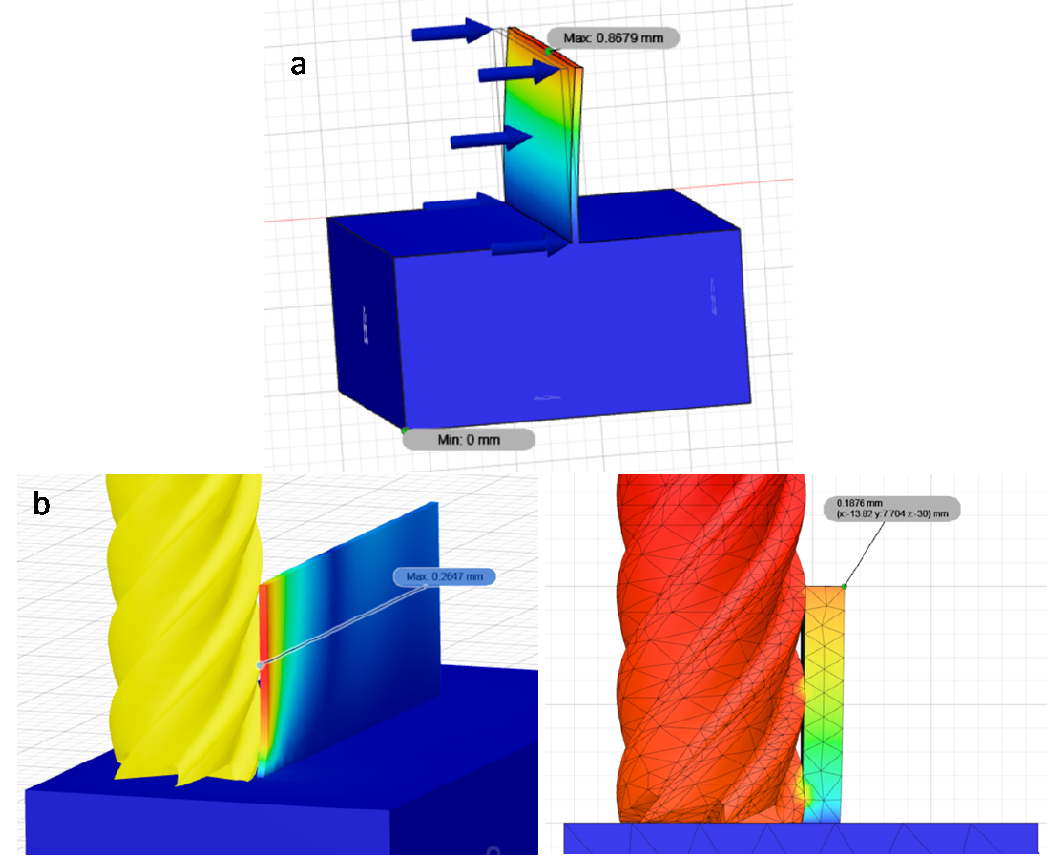
Figure 9. Thin wall deflection simulation made in Fusion 360: ( a ) constant force 100 N; ( b ) pressure of the end mill on the thin